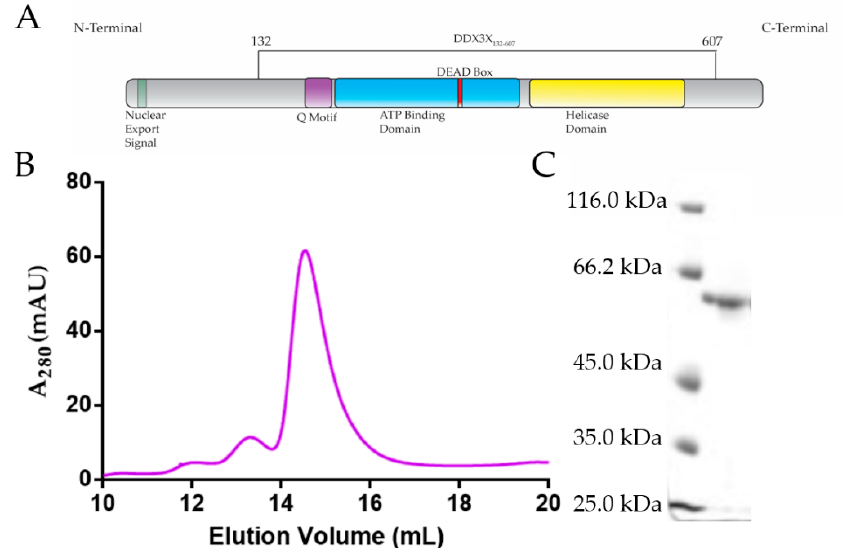
Figure 1. Purification of recombinant DDX3X 132–607 . ( A ) Schematic of human DDX3X’s domain architecture, indicating that DDX3X 132–607 consists of all the major domains, except the nuclear export signal sequence. ( B ) Size exclusion chromatography purification (Superdex 200 Increase GL 10/300) of DDX3X 132–607 demonstrating that DDX3X 132–607 can be purified to homogeneity, eluting at ~14.5 mL. Y-axis represents absorbance at 280 nm while the x-axis represents elution volume. ( C ) SDS-PAGE indicating that the size exclusion chromatography (SEC)-purified DDX3X 132–607 is monodispersed with the correct molecular weight (55.3 kDa).